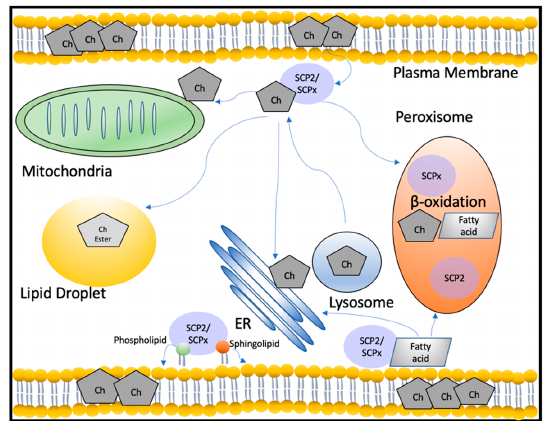
Figure 2. SCP2/SCPx function in the transport and metabolism of cholesterol and other lipids. SCP2/SCPx may transport cholesterol between various cellular membranes and organelles, such as the plasma membrane, mitochondria, lipid droplets, ER, lysosomes, and peroxisomes. Cholesterol intermediates also undergo oxidation in peroxisomes via SCPx for bile acid synthesis. In addition to cholesterol transport, SCP2/SCPx play a role in fatty acid, phospholipid, and sphingolipid transport. SCPx is also a key enzyme in the peroxisomal β -oxidation of fatty acids. Abbreviations: Ch: cholesterol; ER: endoplasmic reticulum.